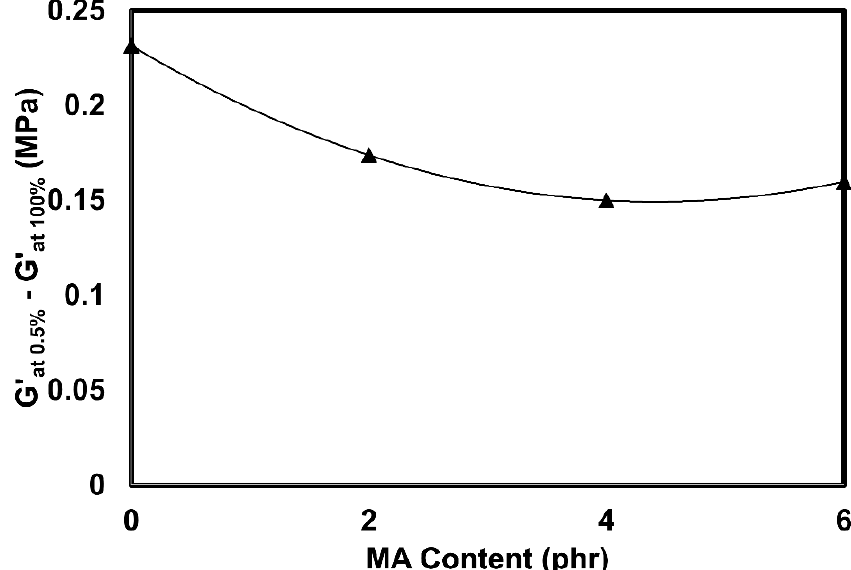
ff ect of NR / HNT and MNR / HNT Figure 10. Payne effect of NR/HNT and MNR/HNT composites. Figure 10. Payne e